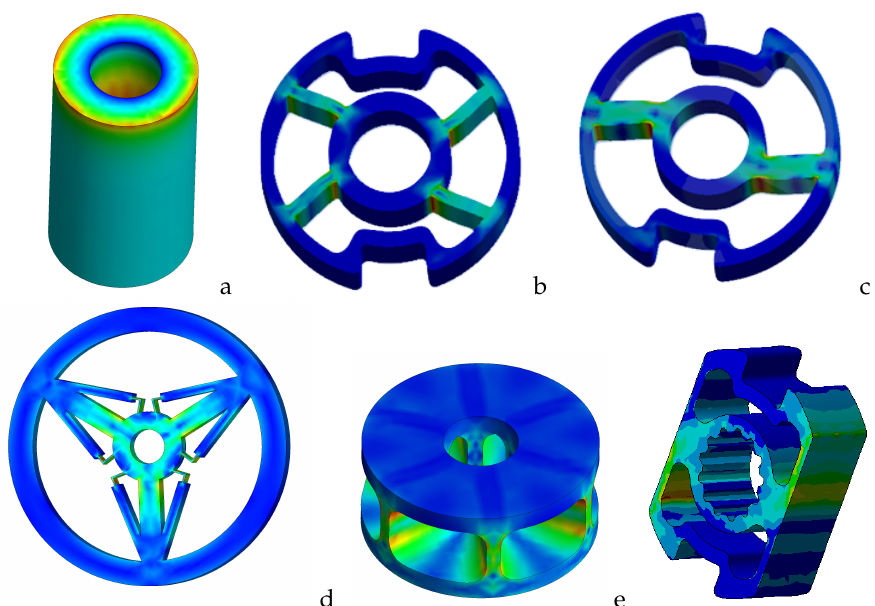
Figure 1. Various torque sensor geometries ( a ) hollow cylinder [3,4,26]; ( b ) hub-sprocket four spokes [5,6,27–30]; ( c ) hub-sprocket two spokes; ( d ) hub-sprocket with 4-bar linkage [9]; ( e ) hollow hexaform [31]; ( f ) new proposed design of Square-Cut Torque Sensor(SCTS), proposed in this communication.